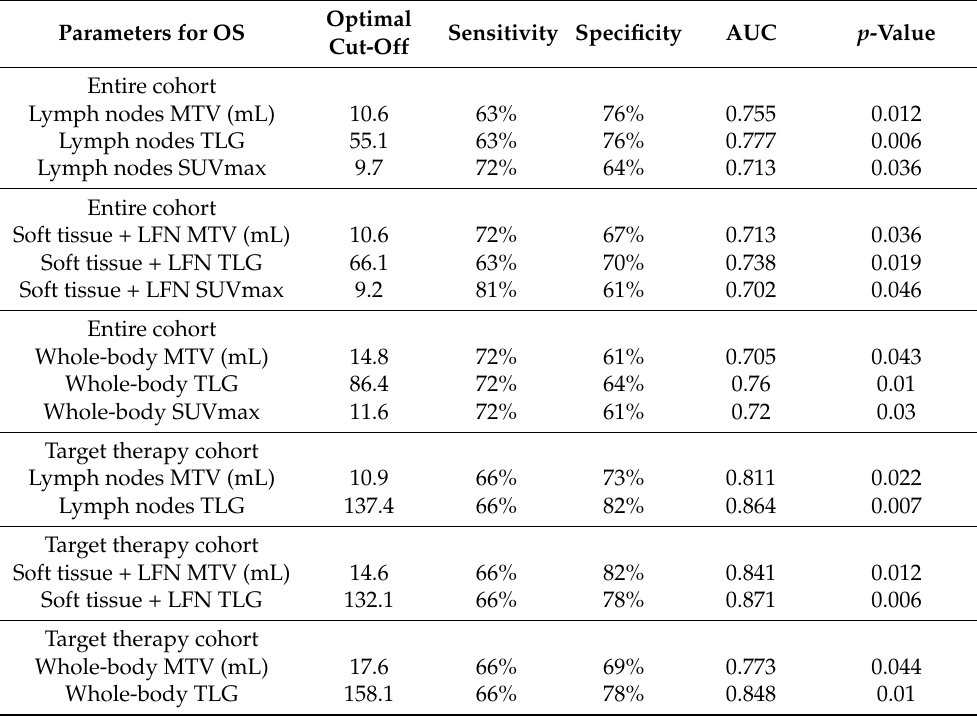
Table 3. Optimal cut-offs of semi-quantitative parameters associated with OS defined using the receiver operating characteristic (ROC)